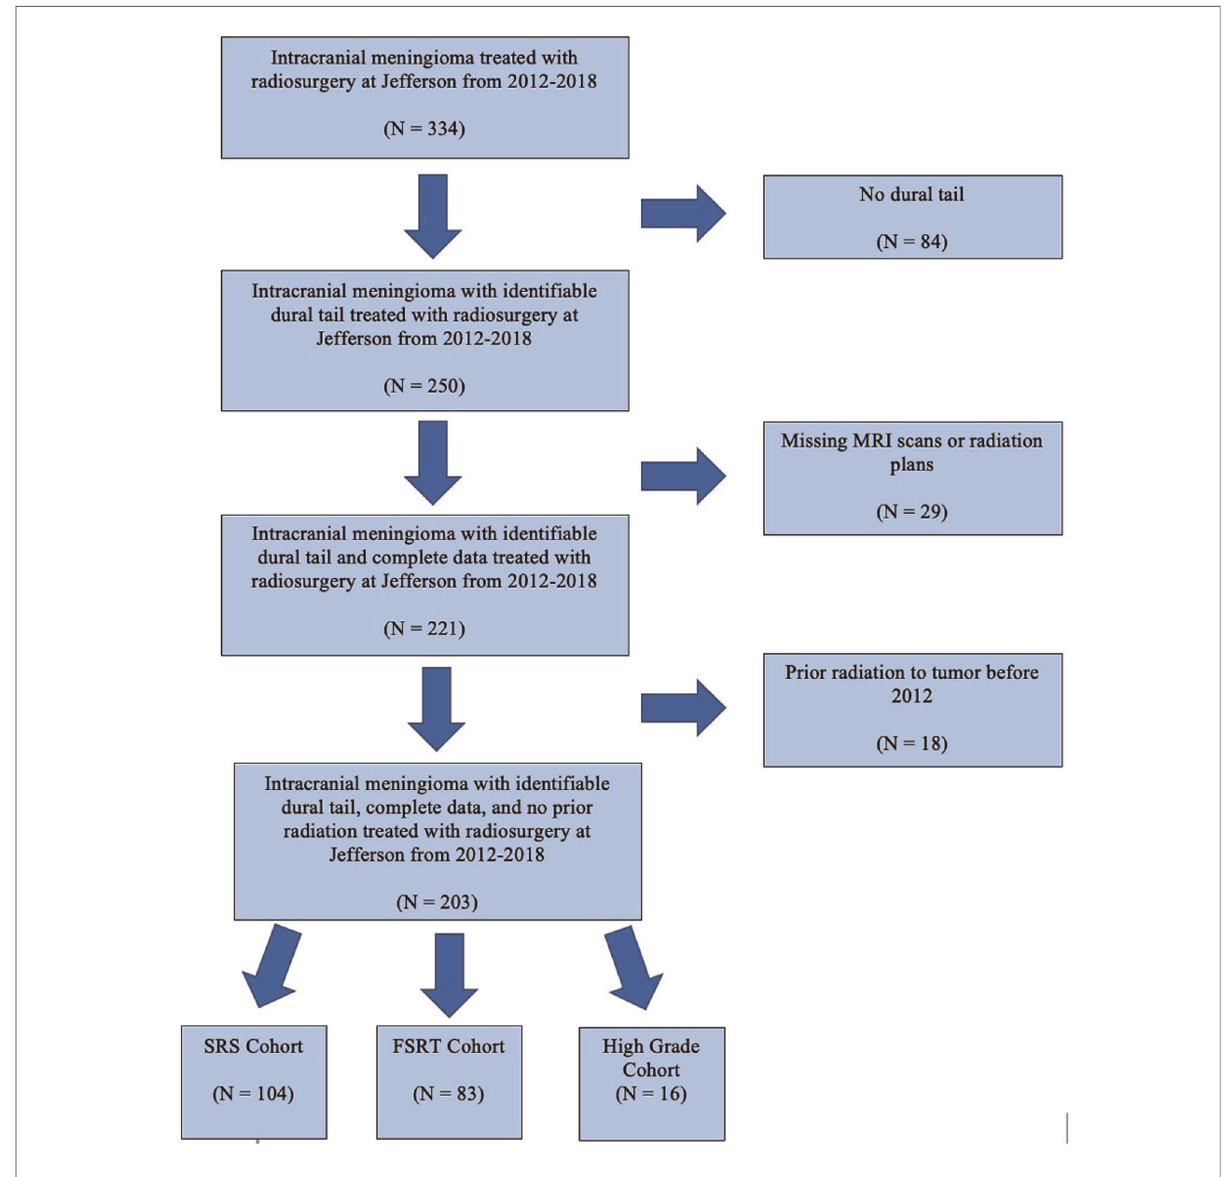
FIGURE 1 Flowchart of the inclusion criteria for this